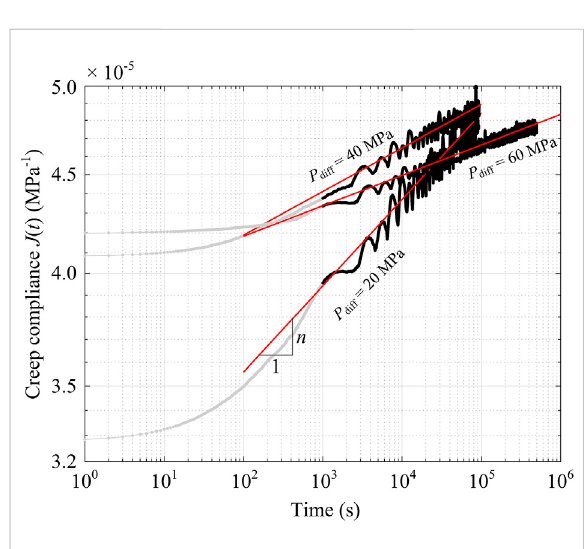
FIGURE 7 Relationships of creep compliance ( J ) and time ( t ) for three differential stress levels (20, 40, 60 MPa) shown in the log-log space (Sample: S2, con fi ning pressure: 20 MPa). The grey data is the fi rst 1000 s which is not considered in the linear regression. Red solid lines are the fi tted results.